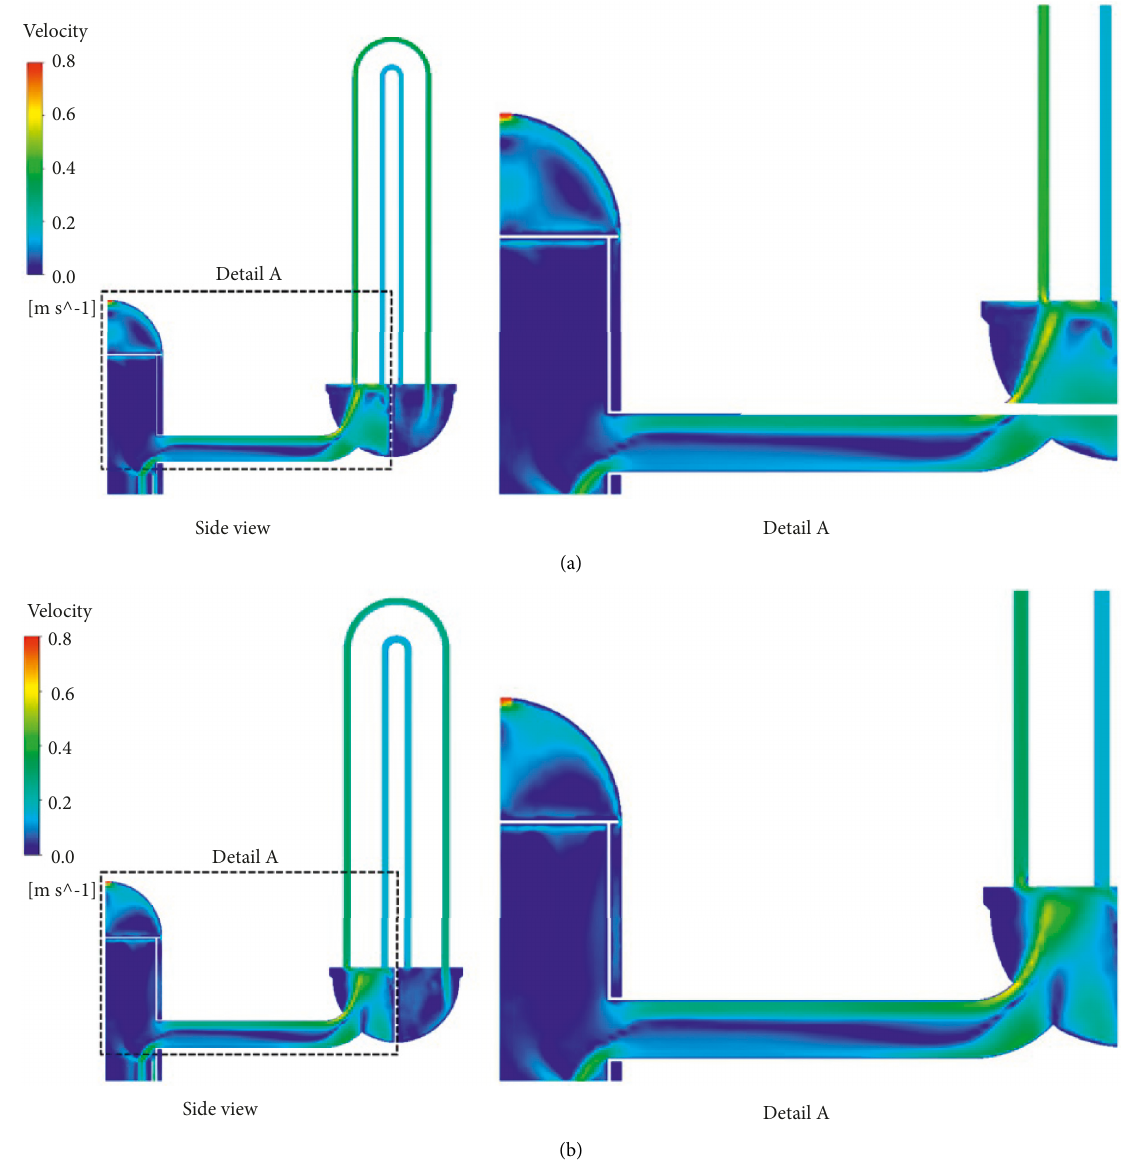
Figure 13: Velocity distribution on symmetry plane (models 2 and 3). (a) Model 2 and (b) model